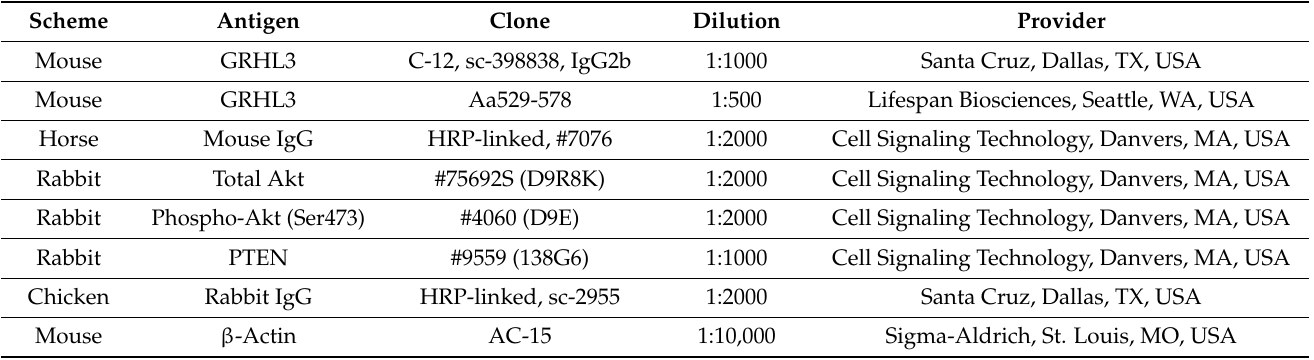
Table 3. Antibodies used for Western